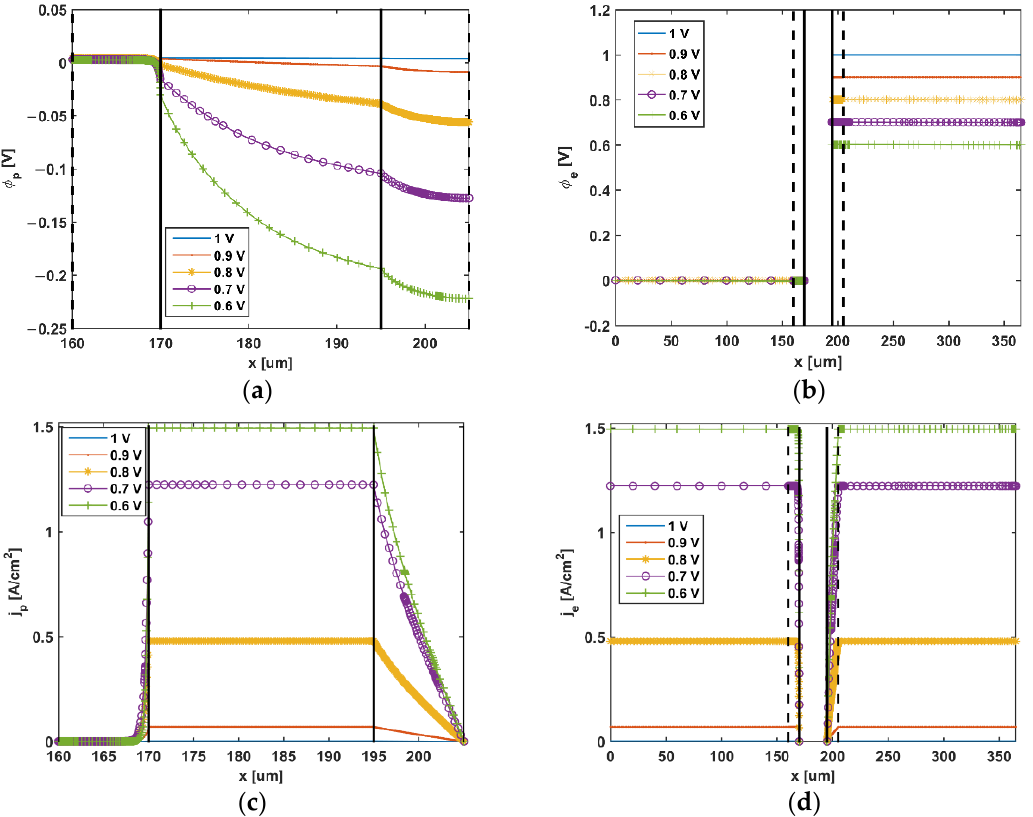
Figure 5. At different cell voltages, calculation of the electrode-electrolyte potentials on through-plane. Subdomain boundaries are indicated by vertical lines. The anode is on the left, the cathode on the right-hand side. ( a ) The Galvani potential of proton-conducting phase; ( b ) the Galvani potential of electron-conducting phase; ( c ) the flux of proton-conducting phase; ( d ) the flux of electron-conducting phase.